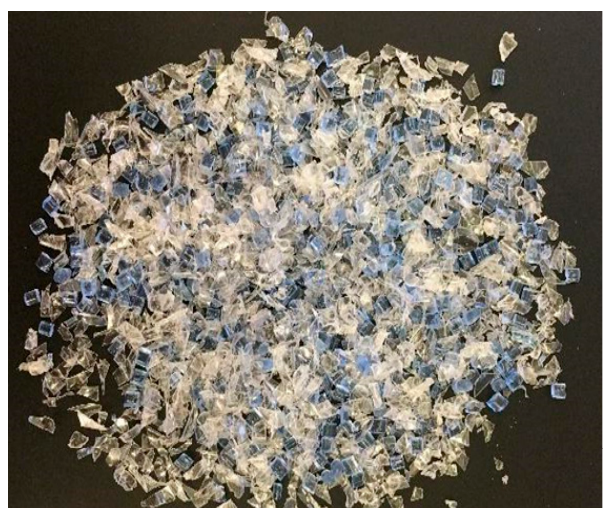
Figure 1. A 50:50 mix of Ultrafuse (blue pellets) and shredded water bottle (clear) to show relative, size, shape, and texture.